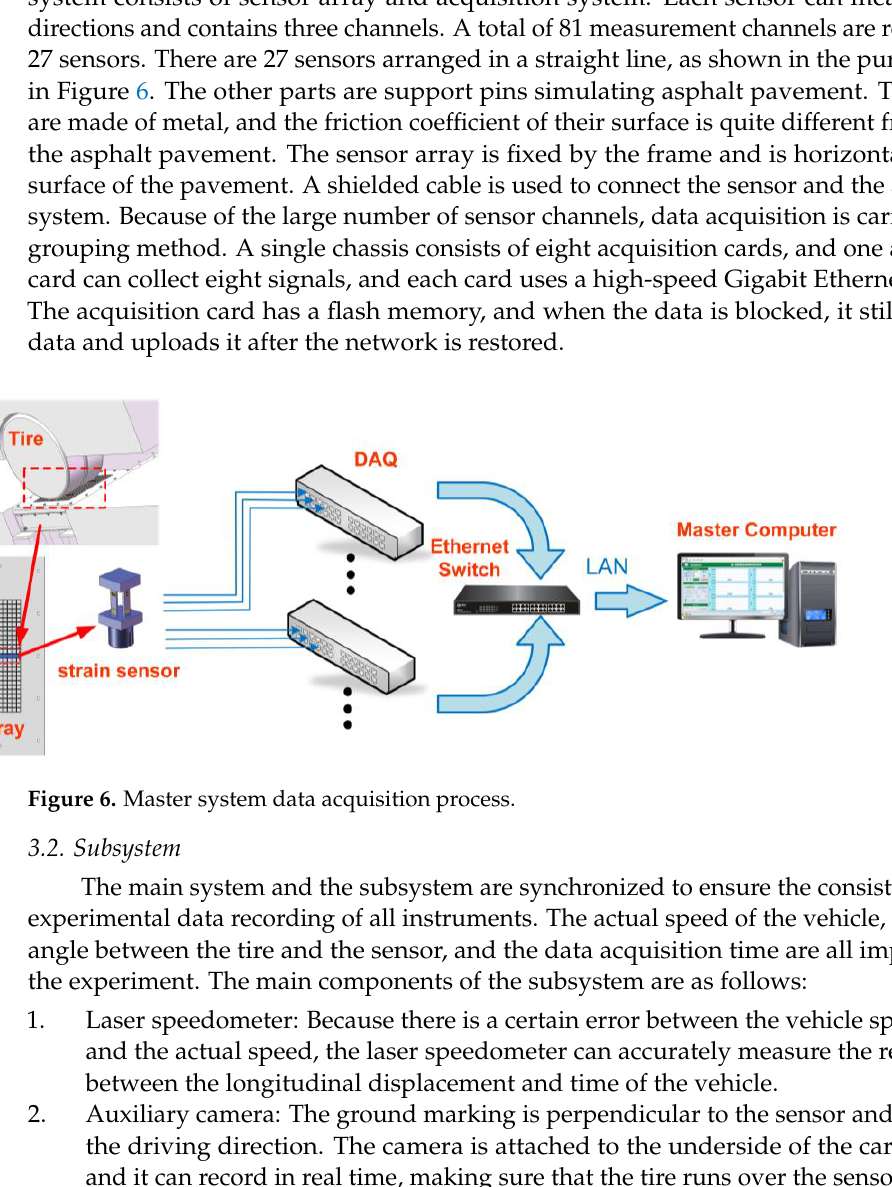
Table 1. Sensors’ average sensitivity. Table 1. Sensors ’ average sensitivity.